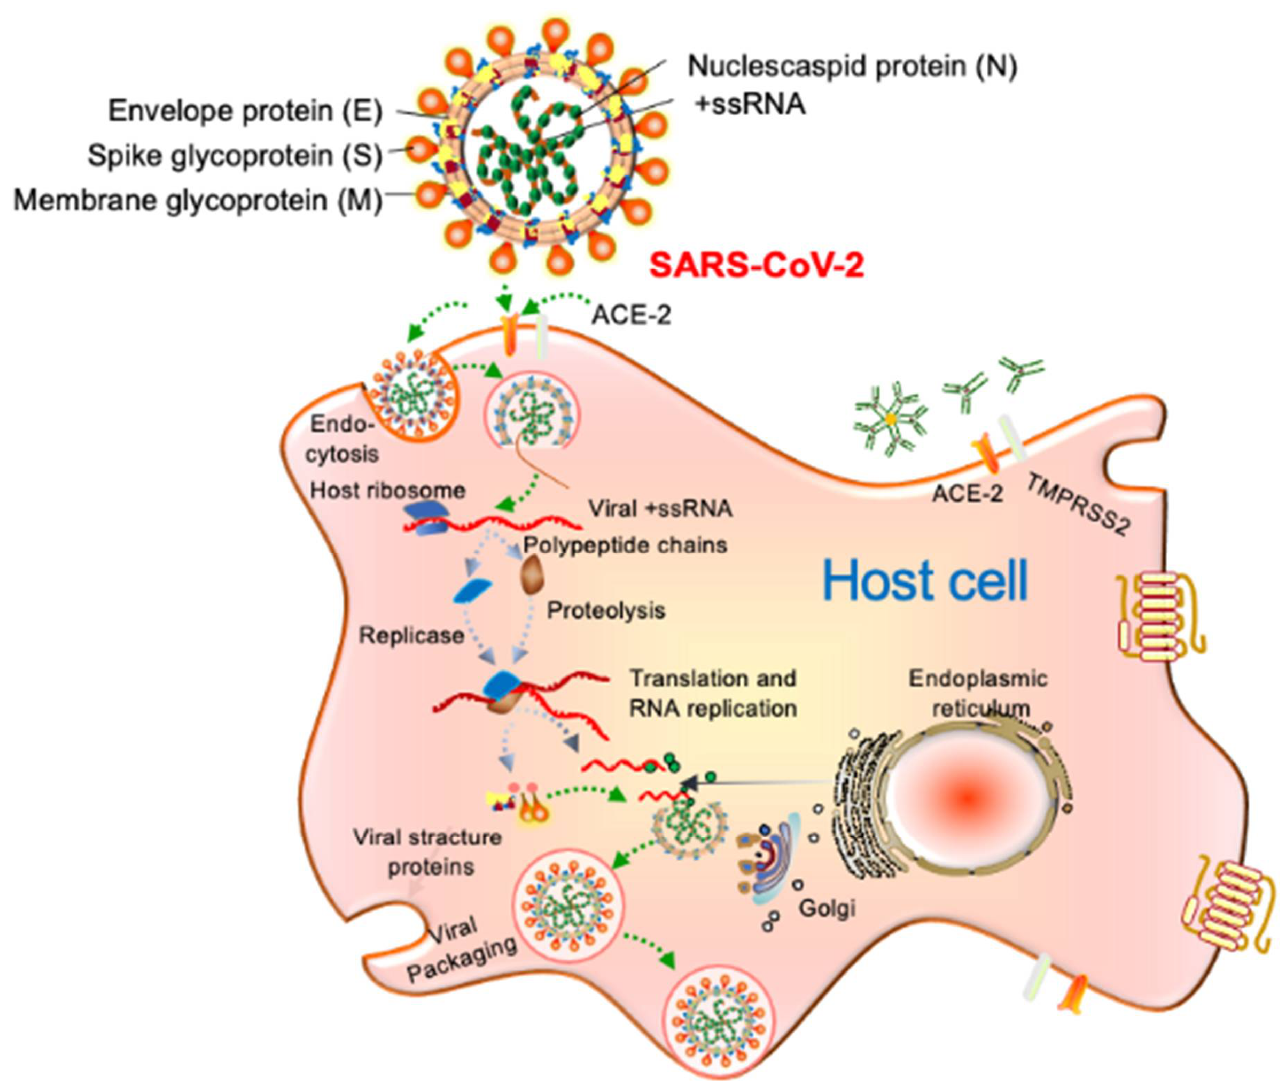
Figure 2. SARS-CoV-19 structure, host cell entry, and replication model. SARS-CoV-2 binds to host cells through the ACE-2 receptor, and, after uncoating, the components of virion use the host cell’s machinery to produce new viruses. Finally, the SARS-CoV-2 virions are released from the host cell by exocytosis.